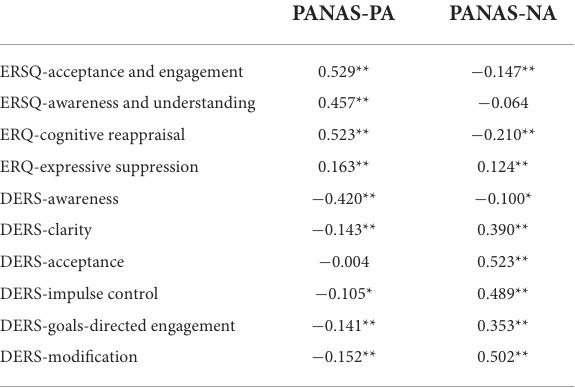
TABLE 2 Correlation between emotion regulation strategies between PANAS-PA and PANAS-NA ( n =